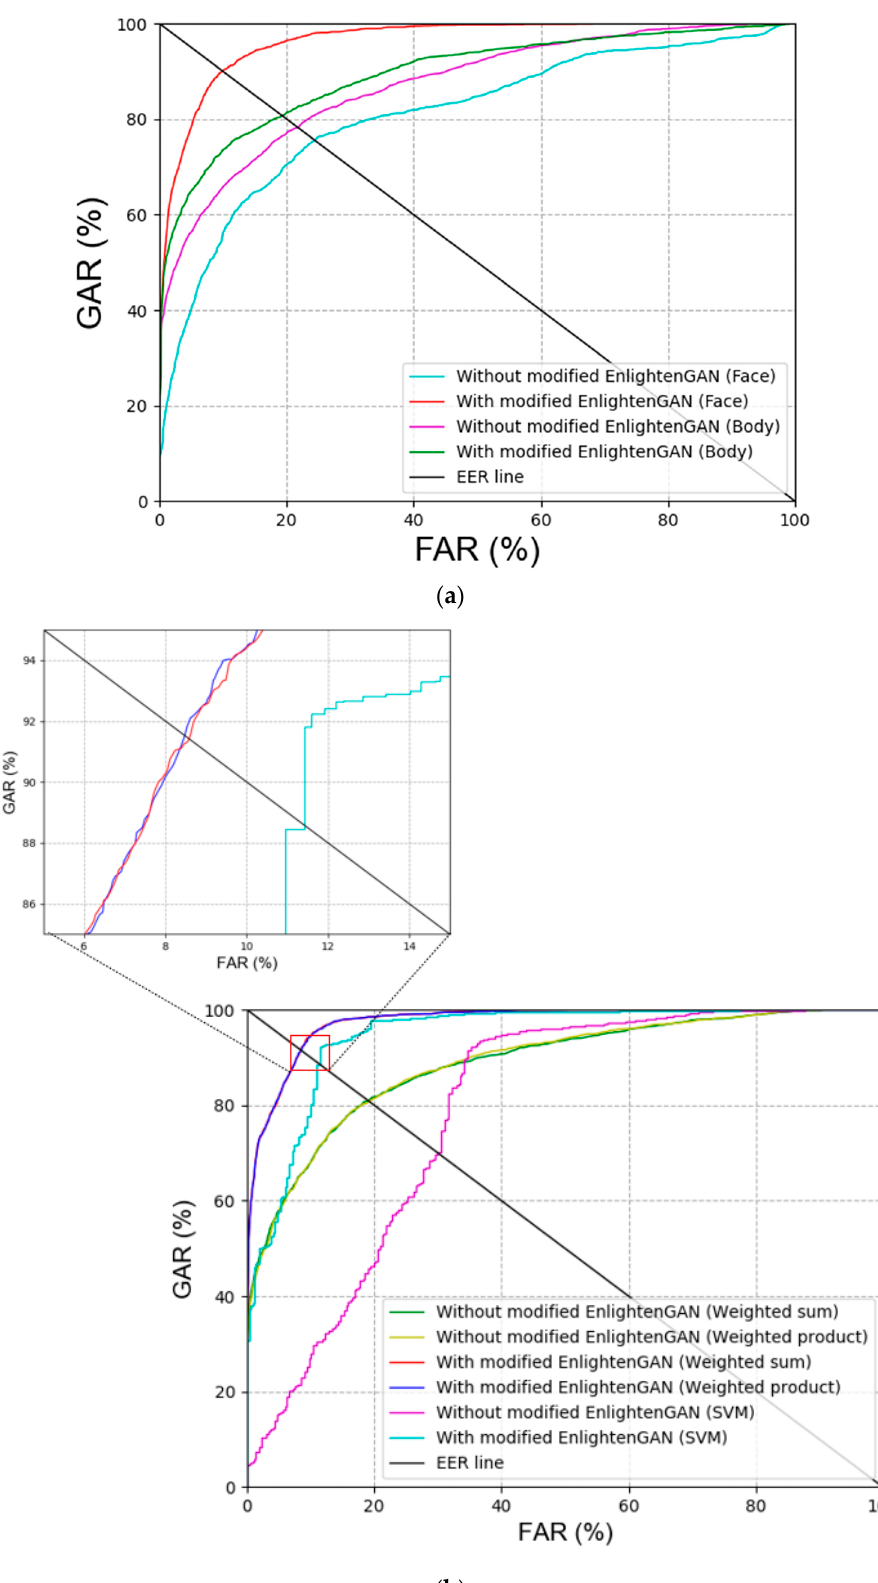
Figure 8. ROC curves of recognition accuracies with or without modified EnlightenGAN. Results of ( a ) face and body recognition, and ( b ) various score-level fusions.